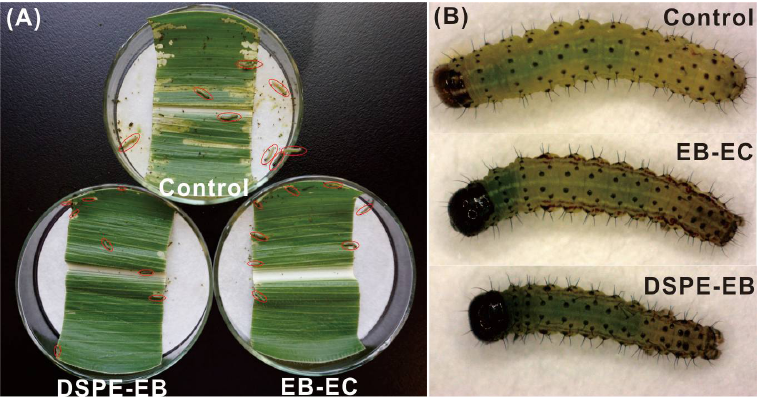
Figure 5. Image of maize leaves with 0.2 mg/L DSPE-EB nanoparticles and EB-EC against third- instar S. furgiperda larvae ( A ) after 24 h; the microscope magnified image of third-instar S. furgiperda